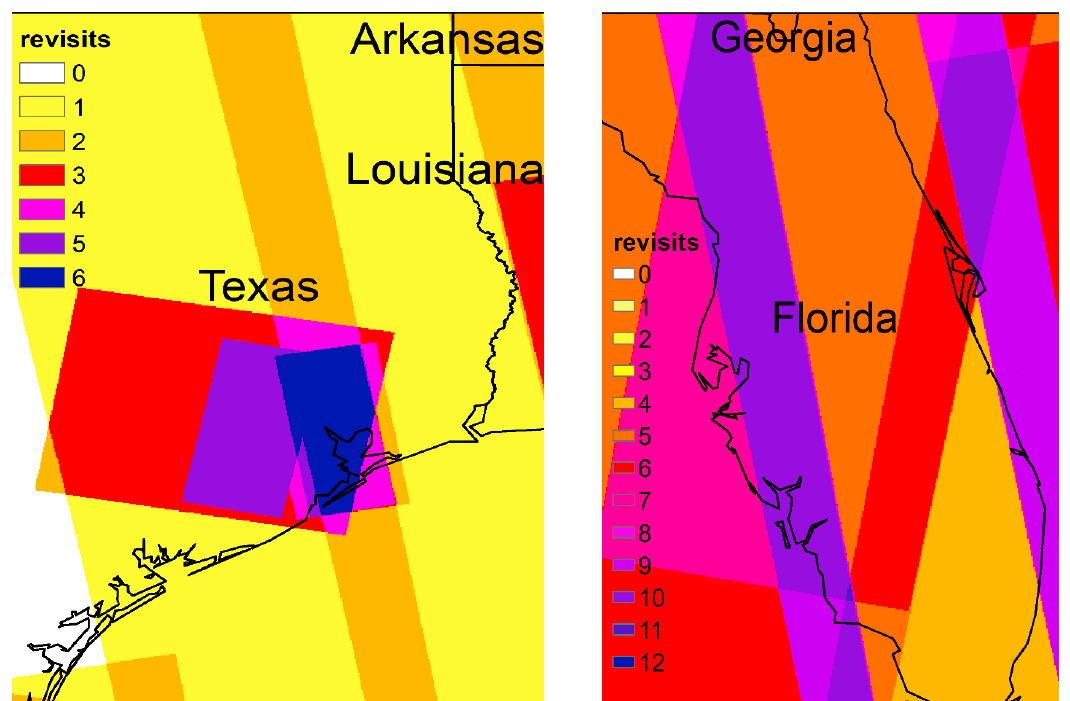
Figure 4. During Harvey, ( a ) Sentinel-1 SAR data availability days and coverage in Texas and ( b ) the inundated times of the Seabrook area.